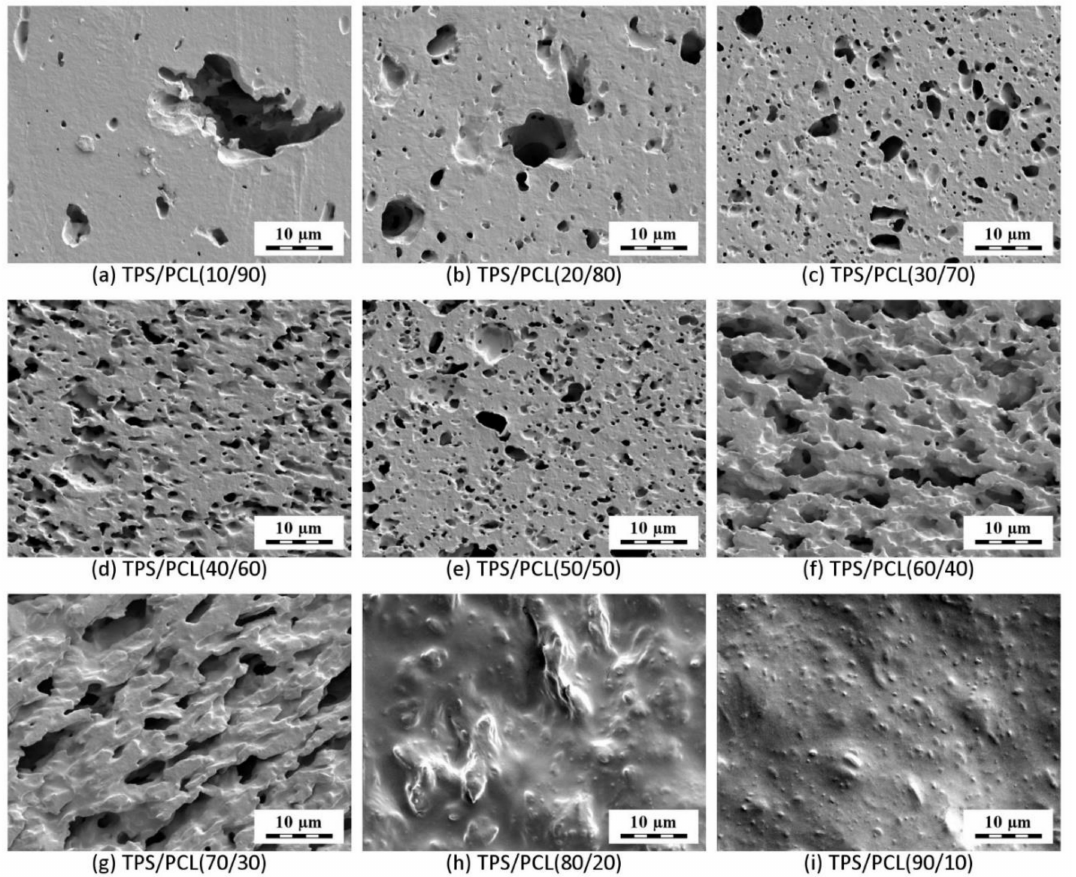
Figure 4. SEM micrographs showing smoothed surfaces of the TPS/PCL blends; the TPS phase was etched off by hydrochloric